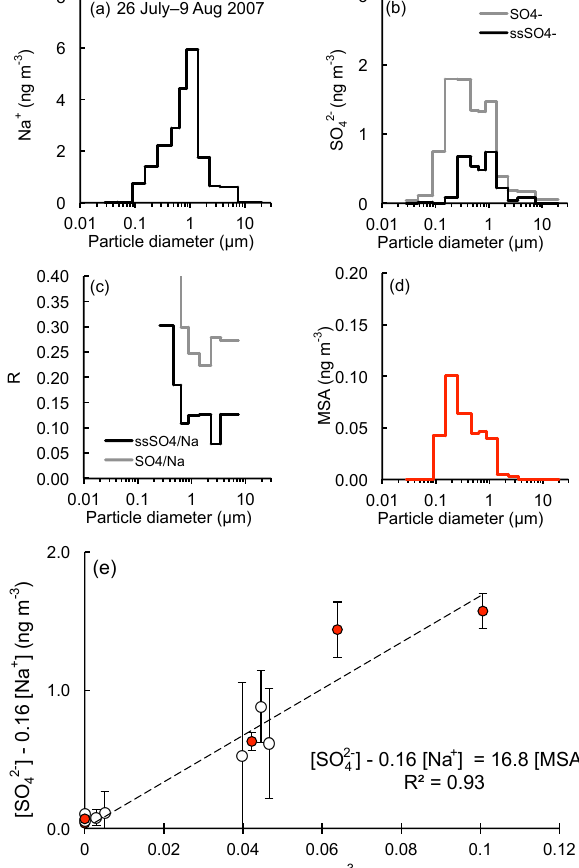
Figure 9. Same as Fig. 8 for aerosol collected between 26 July and 9 August 2007. ( b , grey 4 of biogenic sulfate on particles having a diameter larger than 0.46 µm where the main fraction of sea-salt aerosol is present, and, conversely, we can note the presence of fine sea-salt aerosol.